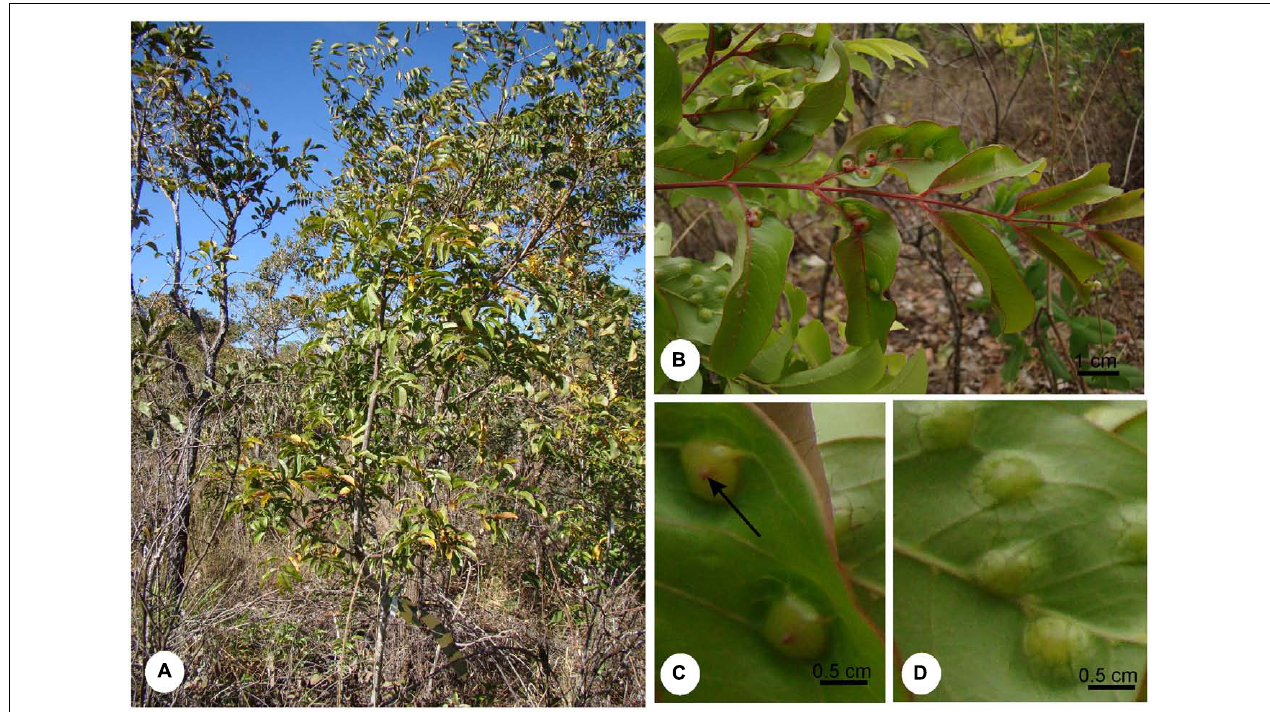
FIGURE 1 | (A) Shrub of Matayba guianensis (Sapindaceae) in a population located at Estação Ecológia do Panga, municipality of Uberlândia, Minas Gerais, Brazil. (B) Galled leaf. (C) Detail of a leaflet adaxial surface evidencing gall ostiole (arrow). (D) Detail of the leaflet abaxial surface evidencing gall